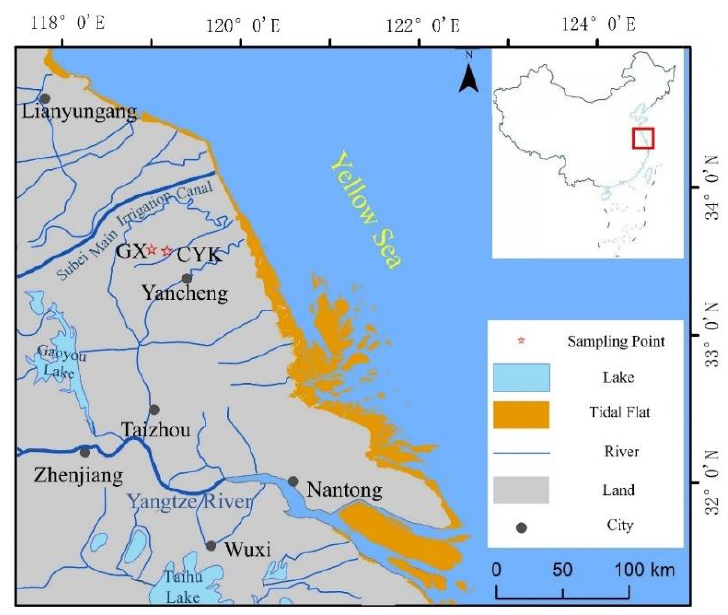
Figure 1. Location of the study area and sampling sites.